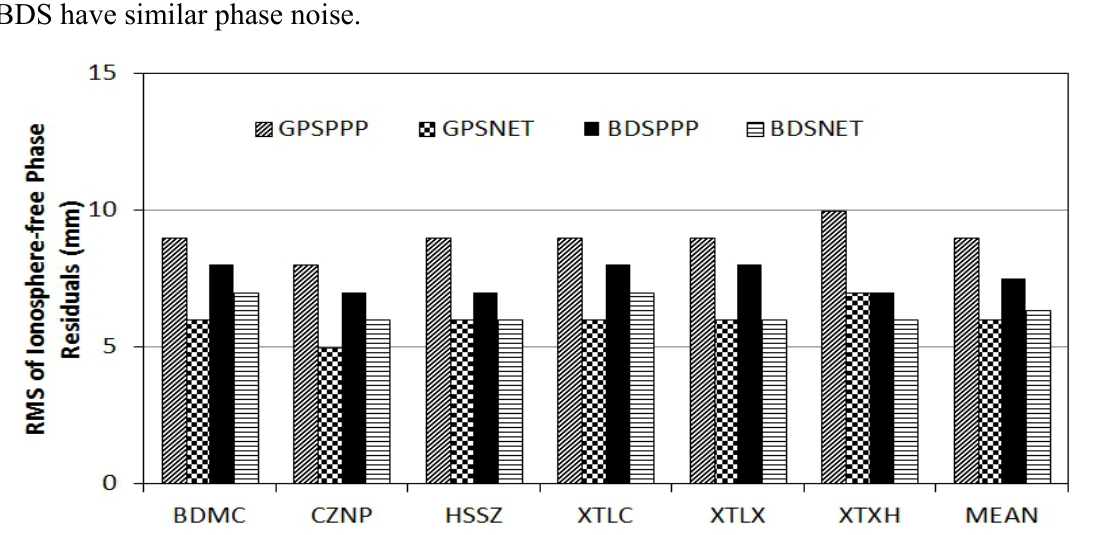
Figure 4. RMS of the ionosphere-free phase observations of the four processing scenarios. RMS of PPP solution is slightly larger than that of the related network solution. GPS and BDS have similar phase